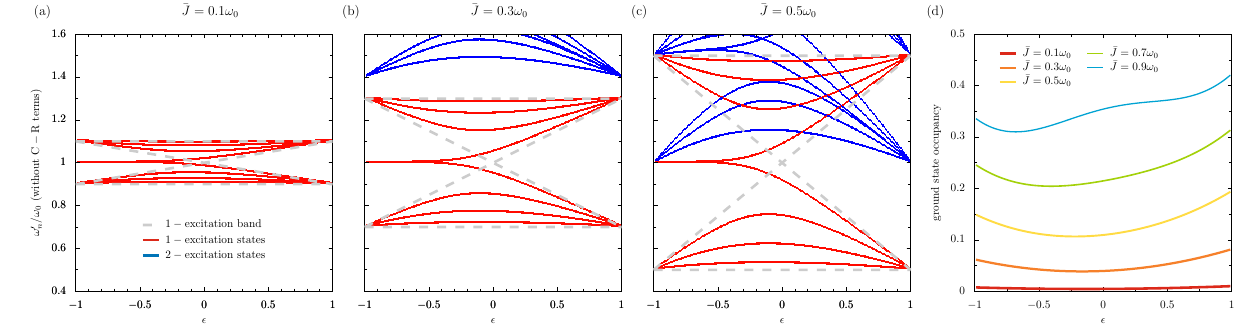
Figure 6. Effective band theory and renormalization of the vacuum. Panels ( a – c ): the RWA eigenfrequencies for a finite chain ω ′ n as a function of the dimerization parameter ǫ , with increasing coupling strength ¯ J in each column [cf. Eq. (7)]. Dashed grey lines: the boundaries of the RWA eigenfrequencies in the one-excitation sector, as found from a periodic calculation in the continuum limit N excitation states are shown in red and two-excitation states are shown in blue. All data above 1.6 ω 0 and below 0.4 ω 0 is cut. Panel ( d ): The occupancy of the ground state of the dimerized chain as a function of ǫ , where the increases with increasing line thickness. In the figure, N